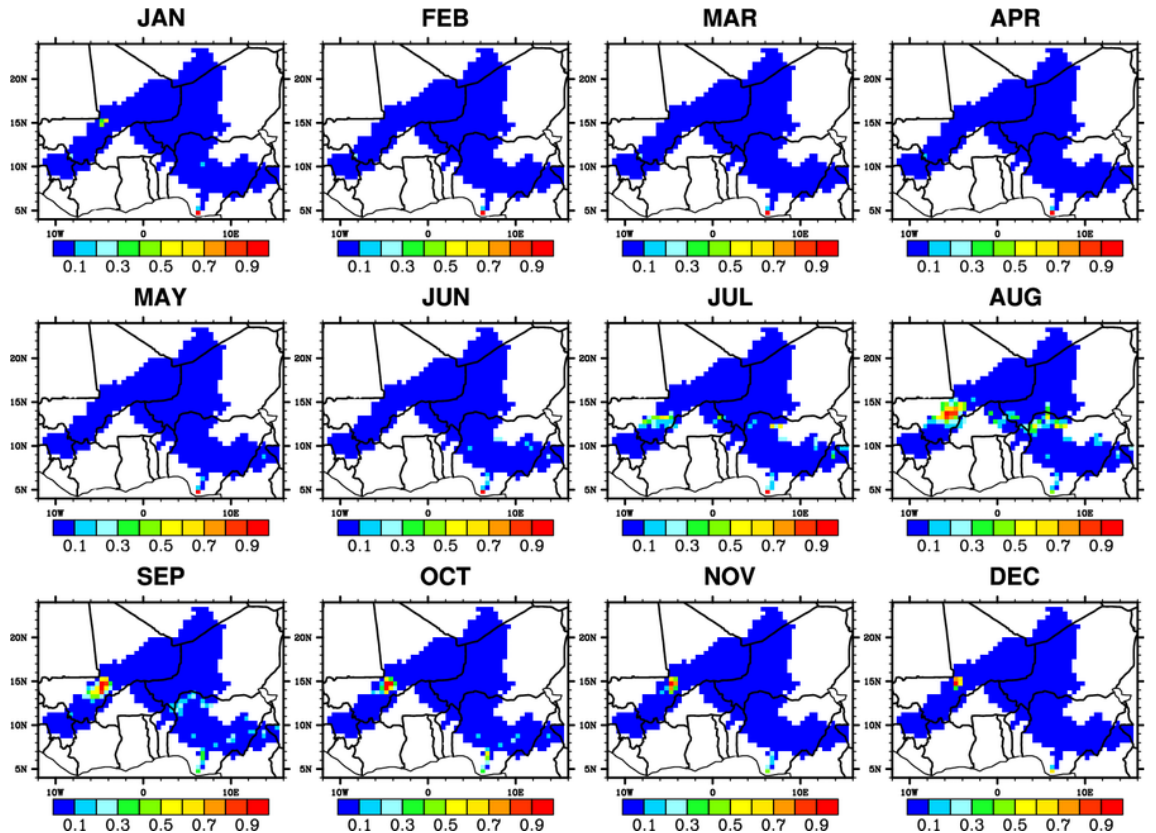
Fig. 9a. Spatial distribution of the normalized CPP flooded fraction averaged over 2002–2007 (the monthly value is devided by the maximum monthly value between 2002 and 2007).